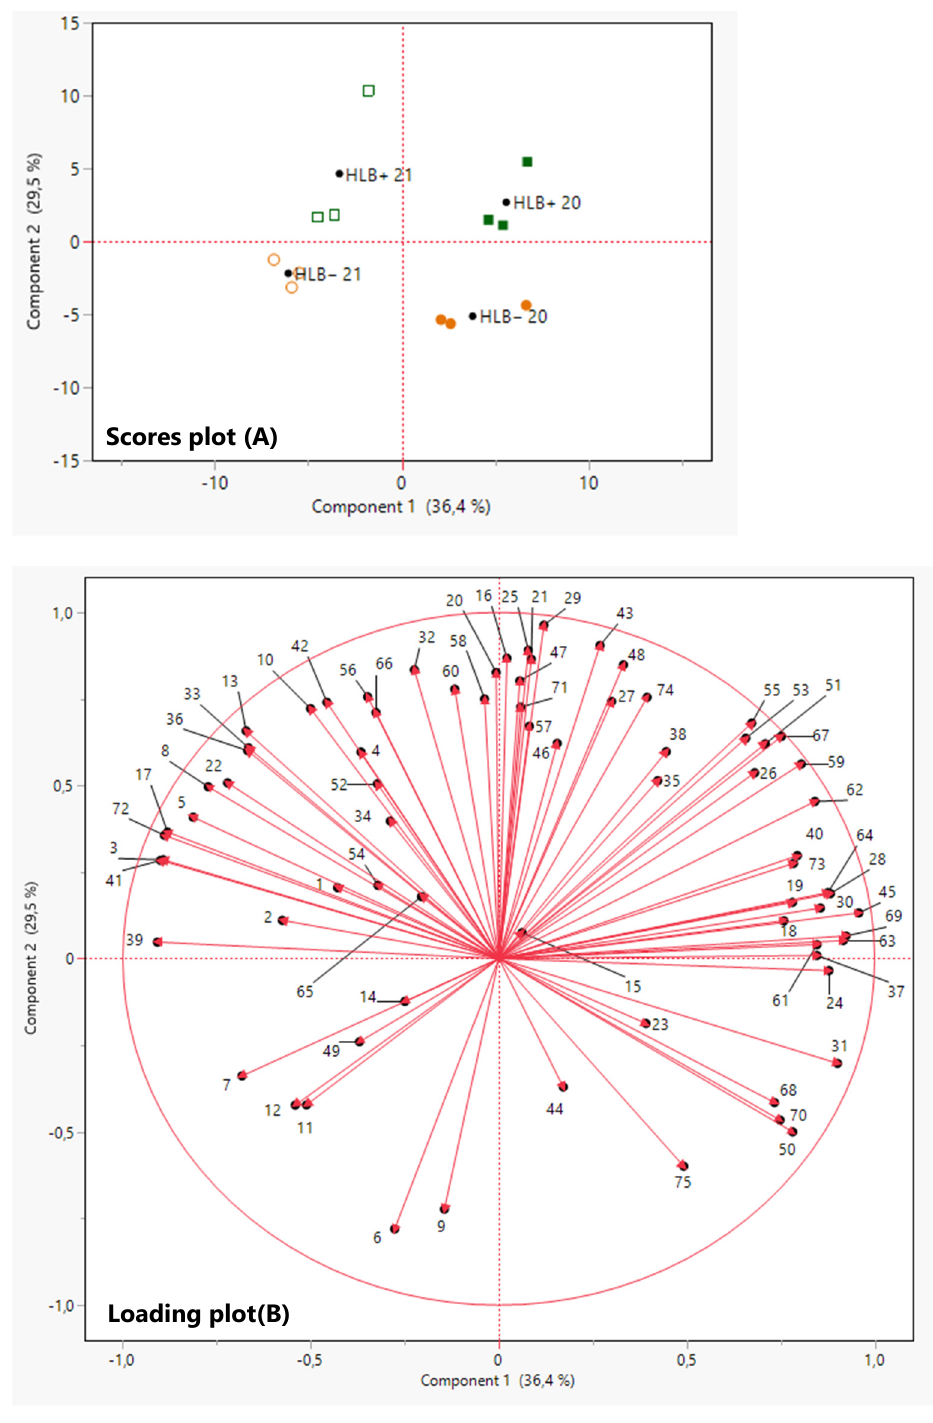
Figure 4. Principal component analysis (PCA) score plot ( A ) and loading plot ( B ) of VOCs in peel oil of ‘Ray Ruby’ grapefruit of healthy (HLB − ) and HLB-affected (HLB+) fruits from 2020 (HLB − 20 and HLB+ 20 ) and 2021 (HLB − 21 and HLB+ 21 ) harvests. VOCs corresponding to the numbers are listed in Table 2.